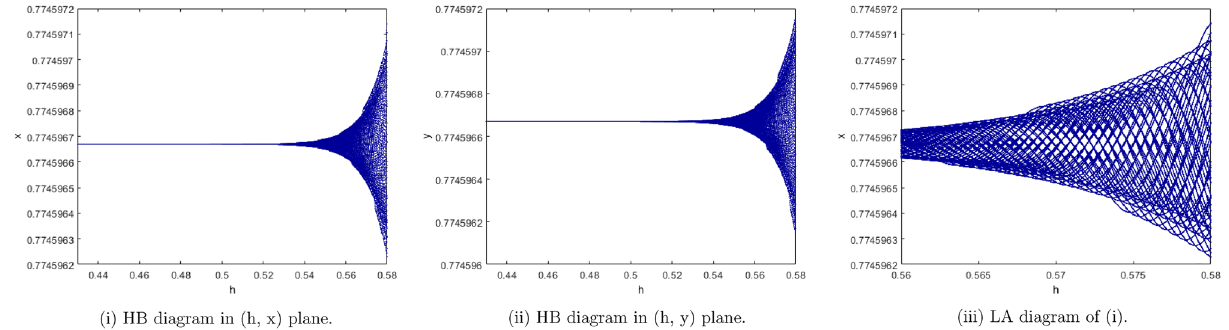
Figure 10. Bifurcation diagrams for the model (i) for values of a = 0.5, b = 1.5, c = 0.5, e = 1.2, h ϵ [0.43, 0.58] and LA corresponding to (i) for h ϵ [0.56,